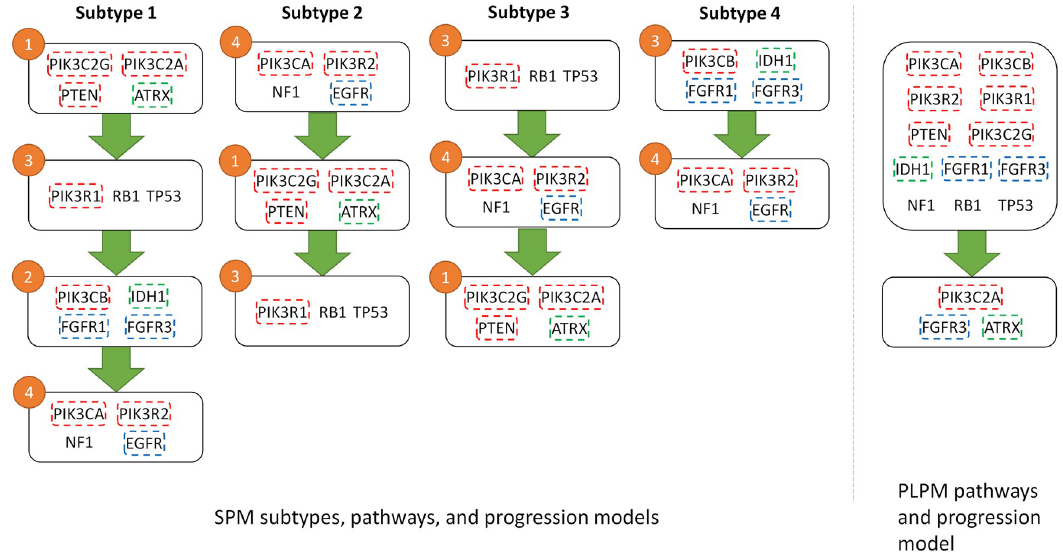
Fig 3. Results for GBM using SPM (left) and PLPM (right). Genes within the same known pathway are coded by the same color. The numbers on pathways refer to the pathway numbers in Fig